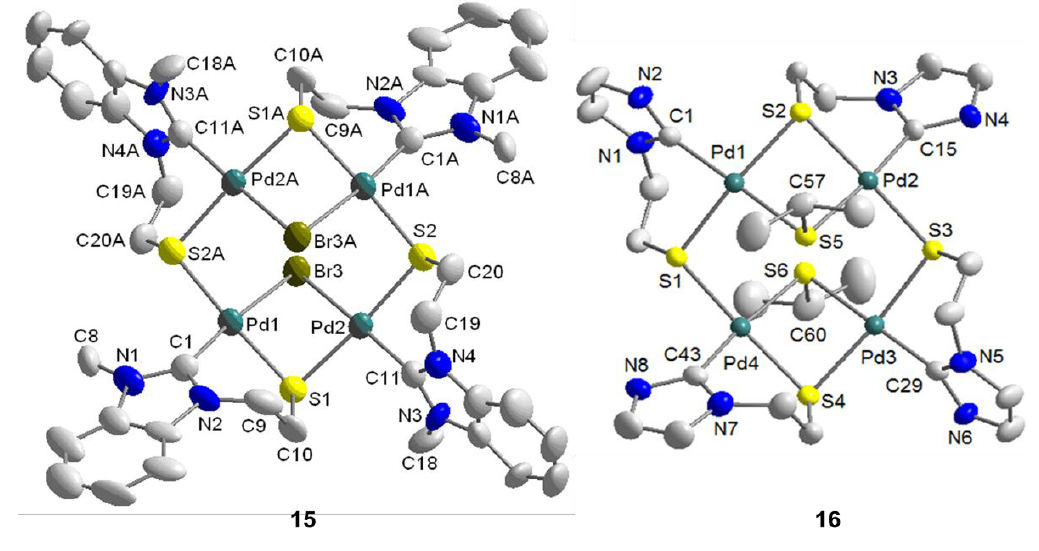
Figure 16. Molecular structures of tetranuclear complexes 15 and 16